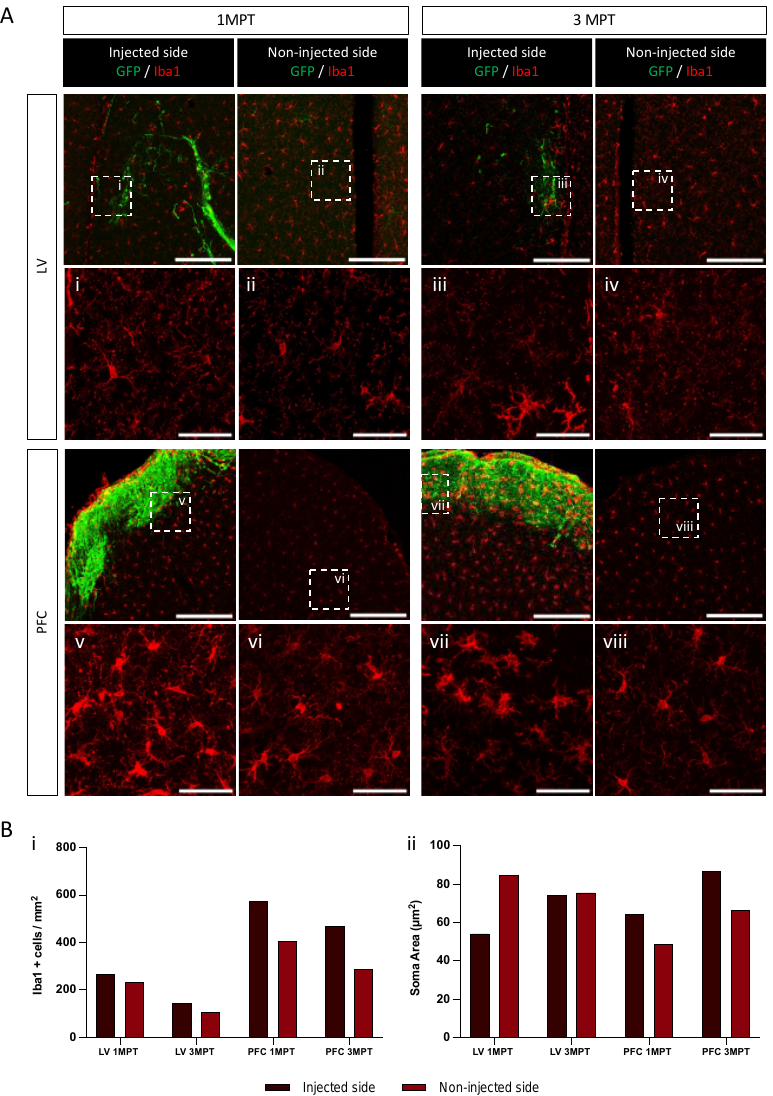
Figure 6. Microglia recruitment around the grafted area, related to Figure 5. ( A ) Confocal images at 1 MPT and 3 MPT of the injected and non-injected sides for LV- and PFC-transplanted mice. The transplanted cells are labelled with GFP, and microglia is shown in red. Pictures i–viii show the higher magnification of the area for the analysis of microglia morphology on one representative brain for each condition. Scale bar = 200 µ m and 5 µ m for i–viii. ( B ) Plot showing microglial density (Bi) and soma area (Bii) for each condition. Quantification was performed on the 20 × images, using the MorphoLibJ plugin in